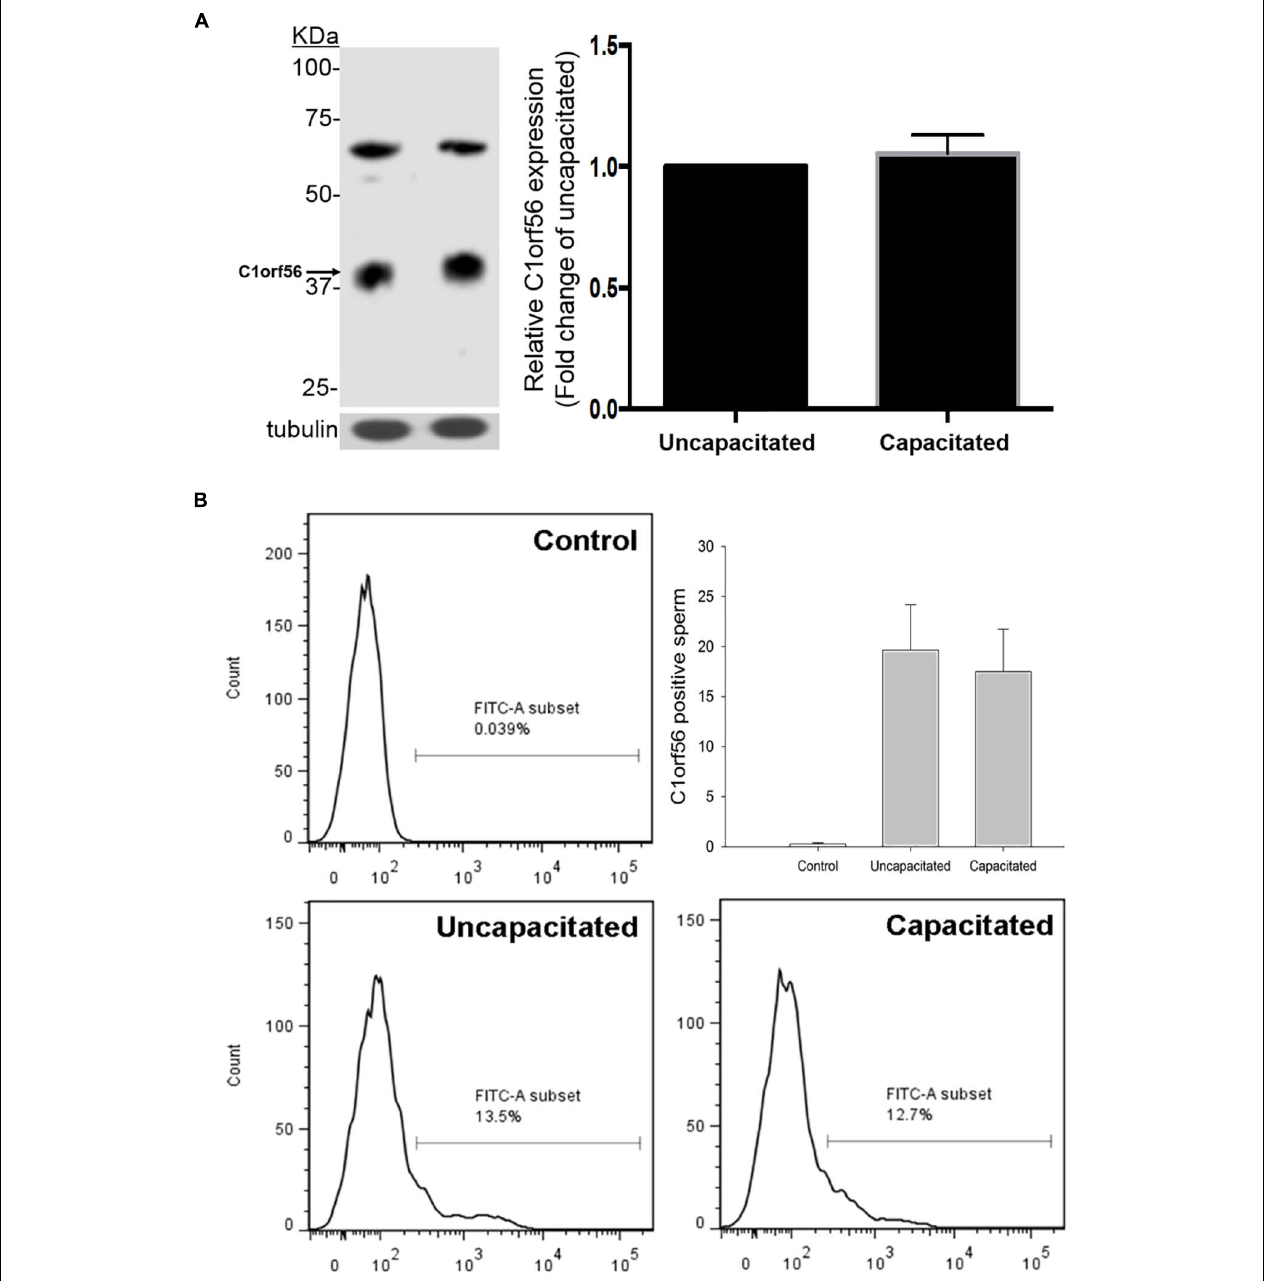
FIGURE 2 | Uncapacitated and capacitated spermatozoa possess similar levels of C1orf56 expression. (A) Washed spermatozoa (2 × 10 6 ) were lysed and resolved in 10% SDS-PAGE followed by Western blotting using anti-C1orf56 antibody. Sample loading was revealed by anti-tubulin antibody. Semi-quantitative comparison of C1orf56 expression between uncapacitated and capacitated sperm samples in Western blotting was also shown. (B) Flow cytometry analysis of the C1orf56 surface expression on uncapacitated and capacitated sperm. Spermatozoa were first incubated with 1 µ g/mL anti-C1orf56 antibody or isotypic-matched antibody from the same species (control) followed by Alexa Fluor-488 fluorescence-conjugated secondary antibody. All data are represented as mean ± standard error of the mean (SEM) ( N =